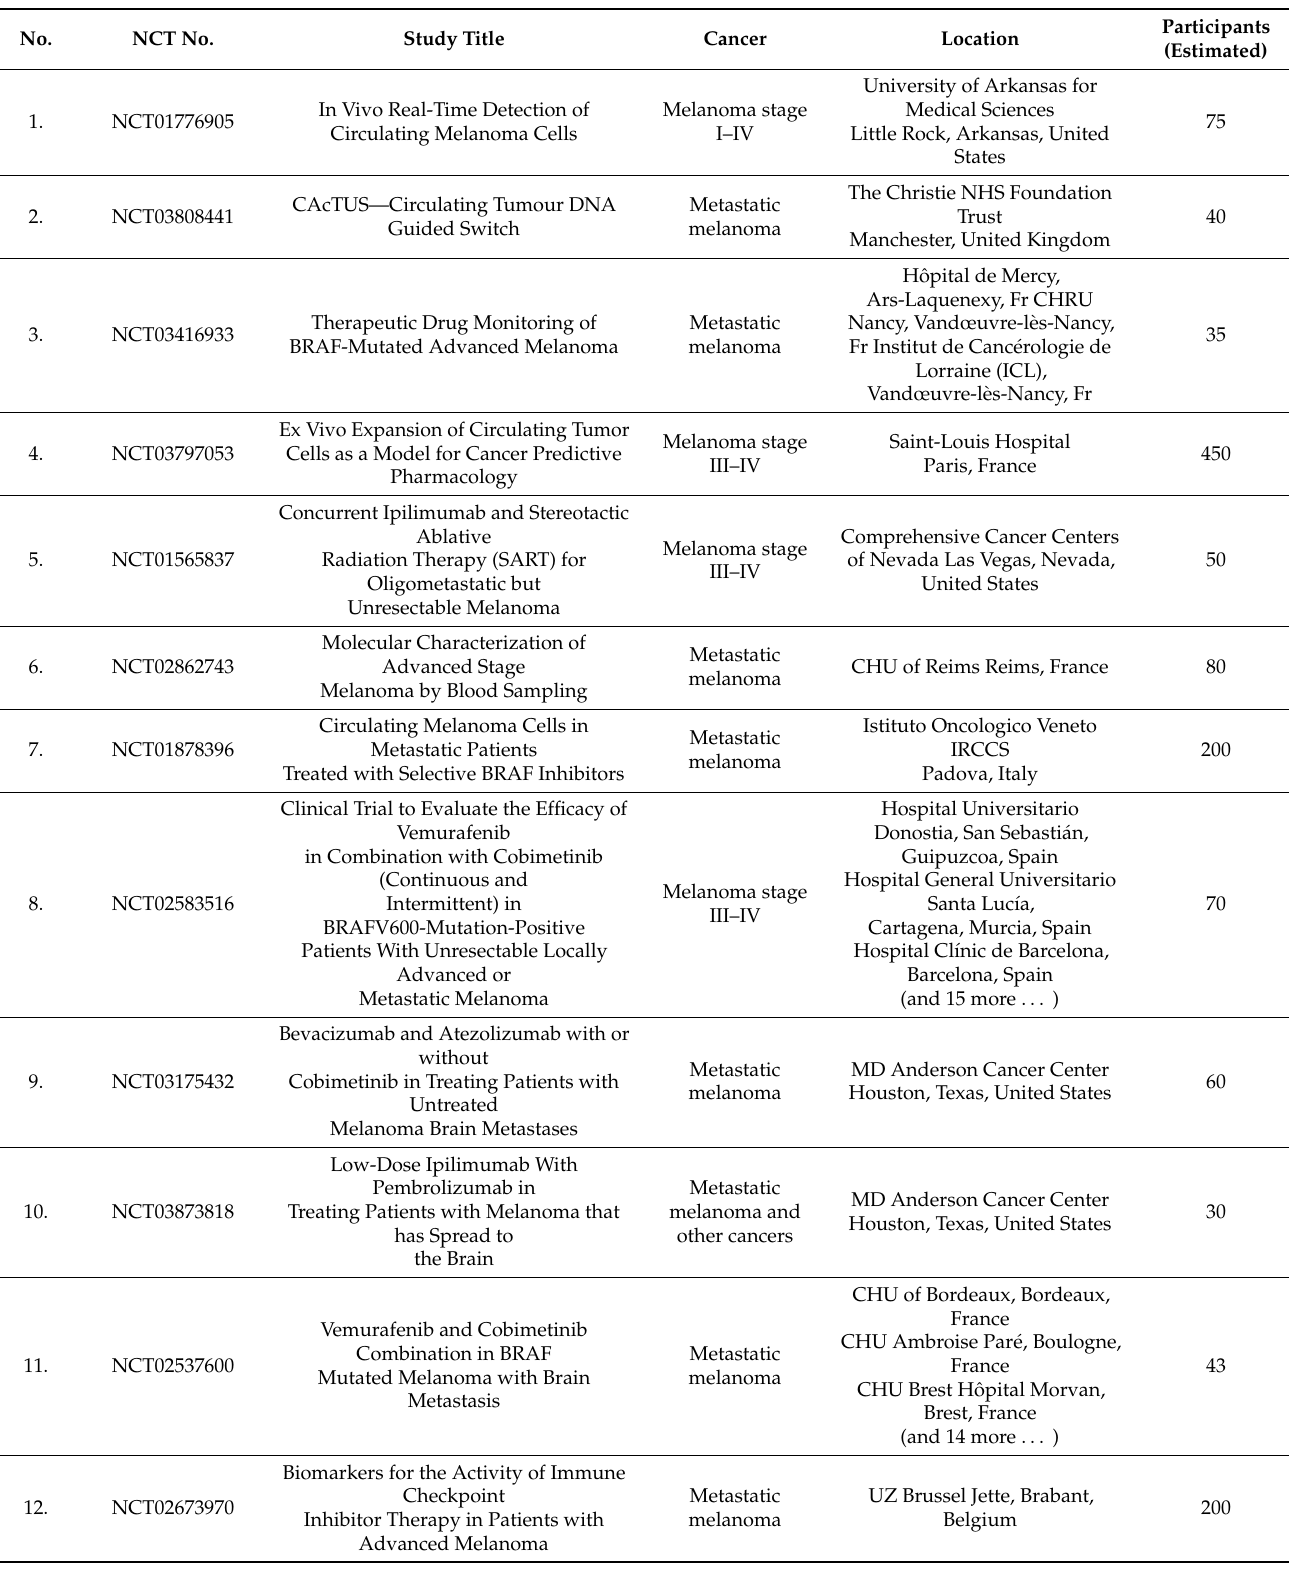
Table 2. Ongoing clinical studies on circulating melanoma cells and circulating tumor DNA (based on ClinicalTrials.gov (accessed on 7 June